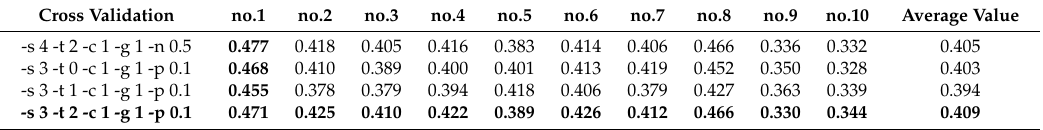
Table A2. Results (R 2 ) using different parameters in the SVR model.